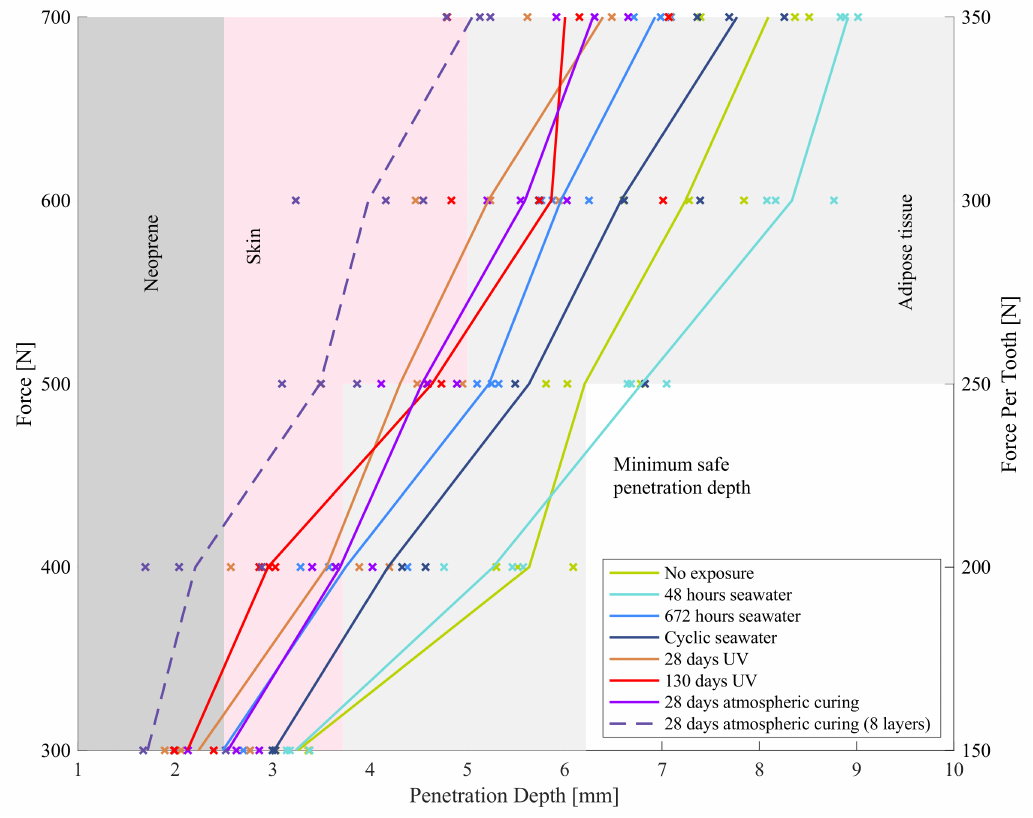
Figure 6. Force versus penetration